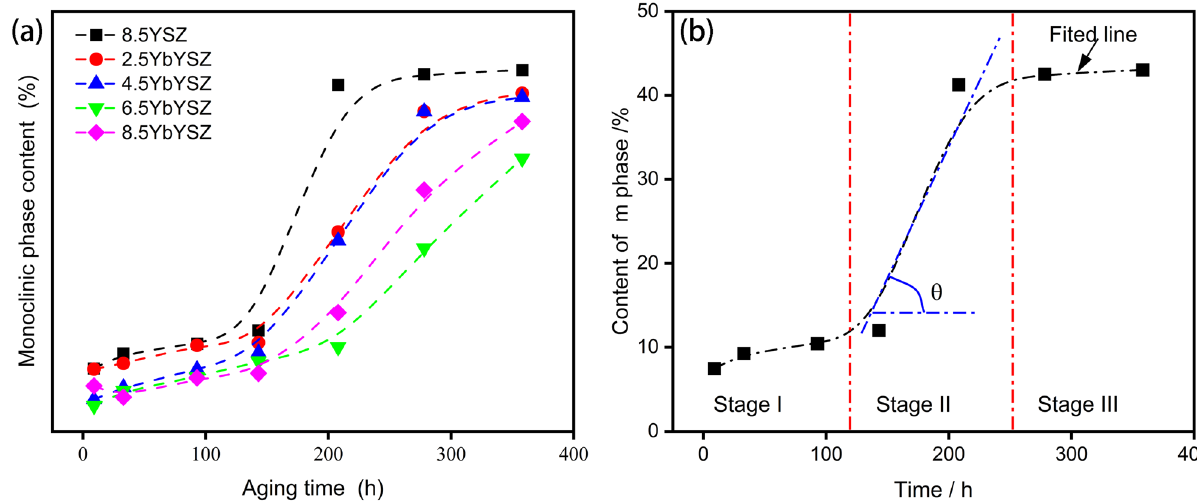
Figure 5. The variation of m phase content of xYbYSZ ceramics ( a ) and fitted line of the m phase content of 8.5YSZ ceramic ( b ) after heat treatment at 1300 °C for 9, 33, 93, 143, 208, 278, and 358